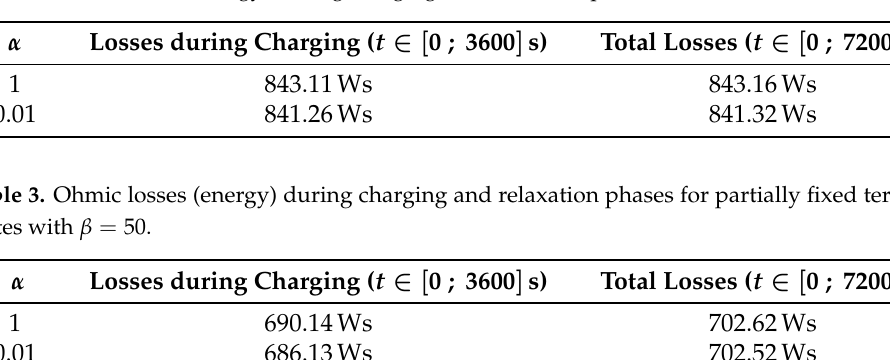
Table 2. Ohmic losses (energy) during charging and relaxation phases for fixed terminal states.